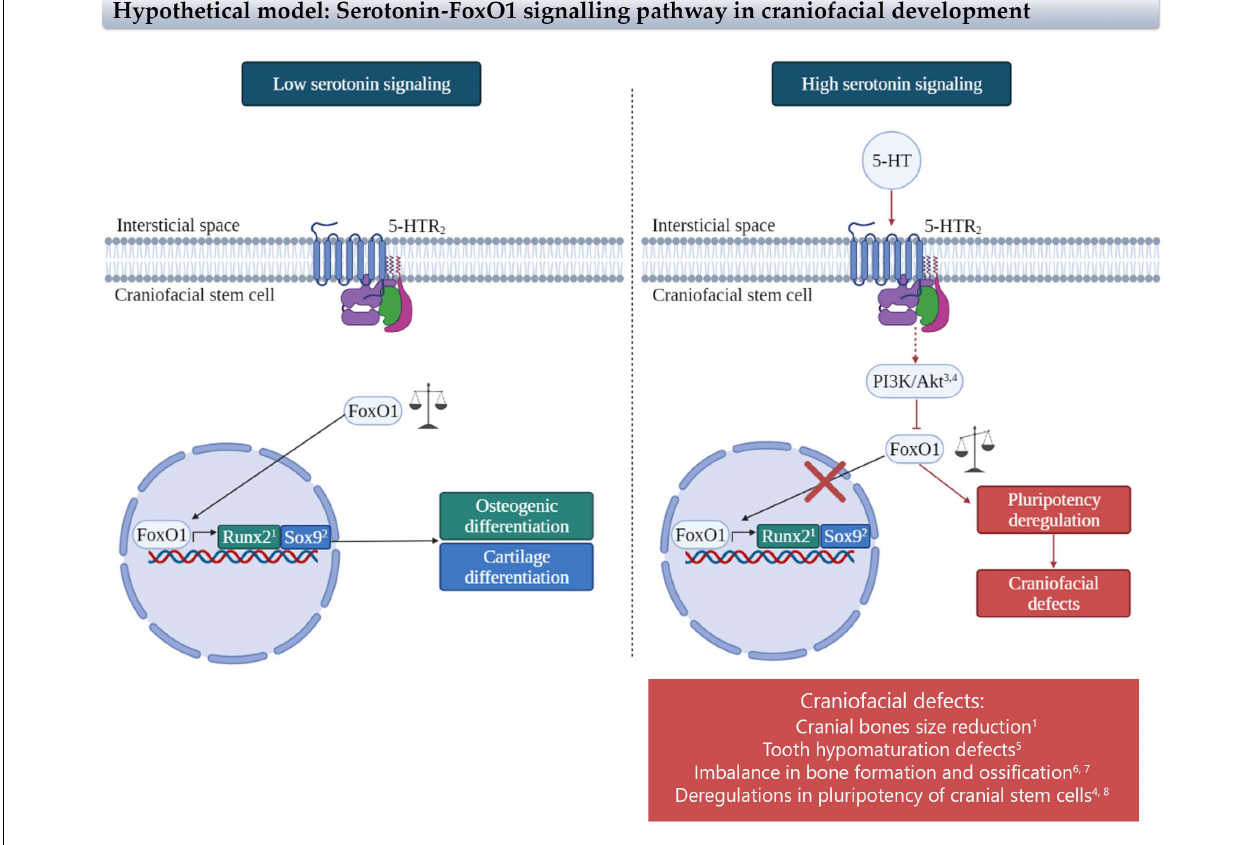
FIGURE 4 | Representation of the proposed link between serotonin and craniofacial defects mediated by FoxO1 transcription factor. Our hypothetical model proposes that under low serotonin signaling, FoxO1 enters to the nucleus generating the transcription of osteogenic (Runx2) and cartilage (Sox9) differentiation genes promoting the differentiation of bones and cartilages. On the contrary, under high serotonin signaling, the activation of the serotonin two receptor, through PI3K/AKT signaling pathway, impedes the entrance of FoxO1 to the nucleus, generating an imbalance in the pluripotency genes related to craniofacial defects. Craniofacial defects observed are included. References: 1 Teixeira et al., 2010; 2 Kurakazu et al., 2019; 3 Lv et al., 2017; 4 Ormsbee Golden et al., 2013; 5 Poche et al., 2012; 6 Almeida et al., 2007; 7 Iyer et al., 2013; 8 Zhang et al.,